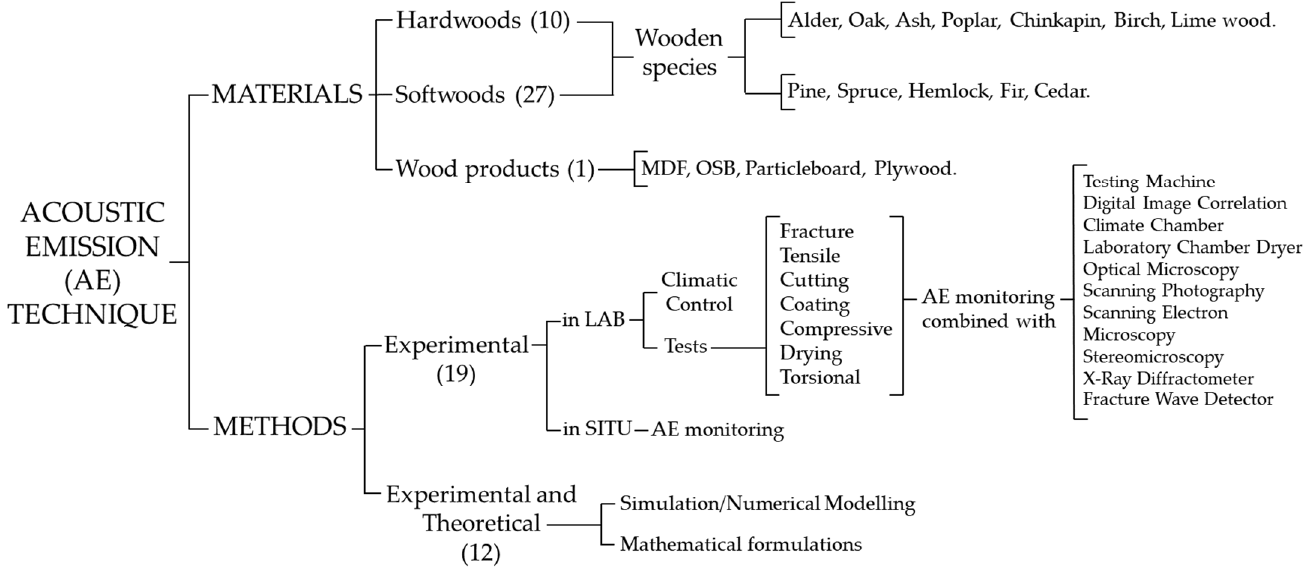
Figure 6. Information extracted from the selected documents. In these works, the Acoustic Emission technique was used alone or combined with other techniques. In brackets the number of